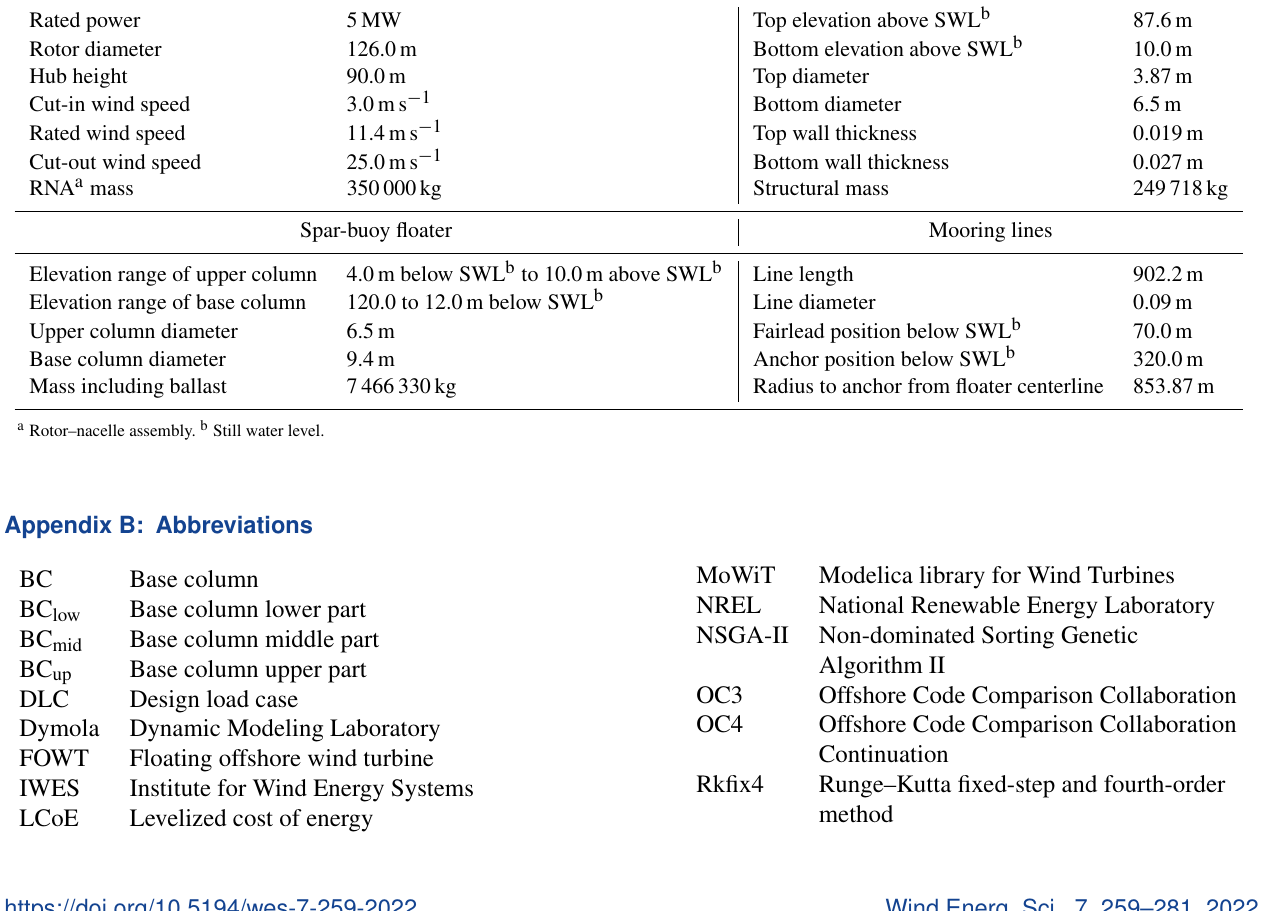
Table A1. Main properties of the OC3 phase IV FOWT system (Jonkman, 2010; Jonkman et al., 2009). Wind